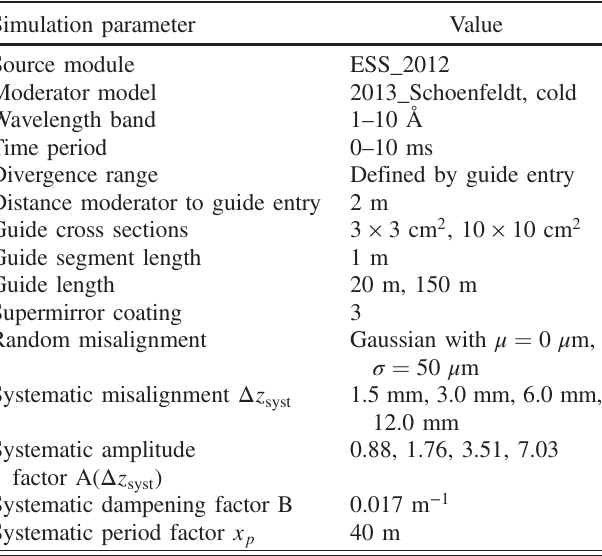
TABLE I. Parameters used in the VITESS simulations.